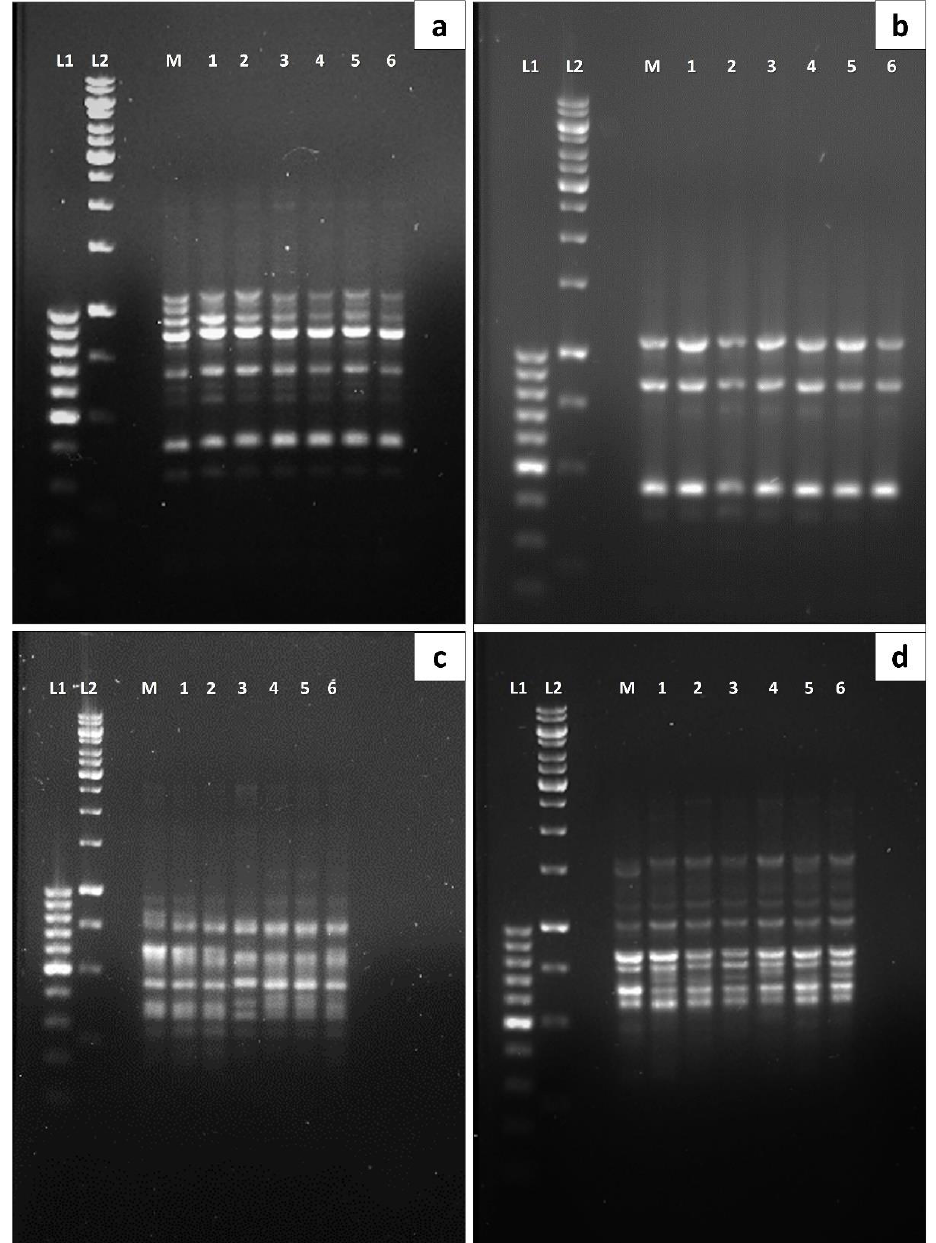
Figure 3. RAPD and SCoT marker profiles of mother plant and micropropagated plants (first to sixth subculture cycles) of Ficus carica cv. Violette de Solliès : ( a ) OPU_U20; ( b ) OPC_20; ( c ) SCoT_21; ( d ) SCoT_24. Lane L1 and L2 represent the 100 bp and 1 kb ladder DNA, respectively; lane M represents mother plant and lanes 1 – 6 represent the micropropagated plants from first to sixth